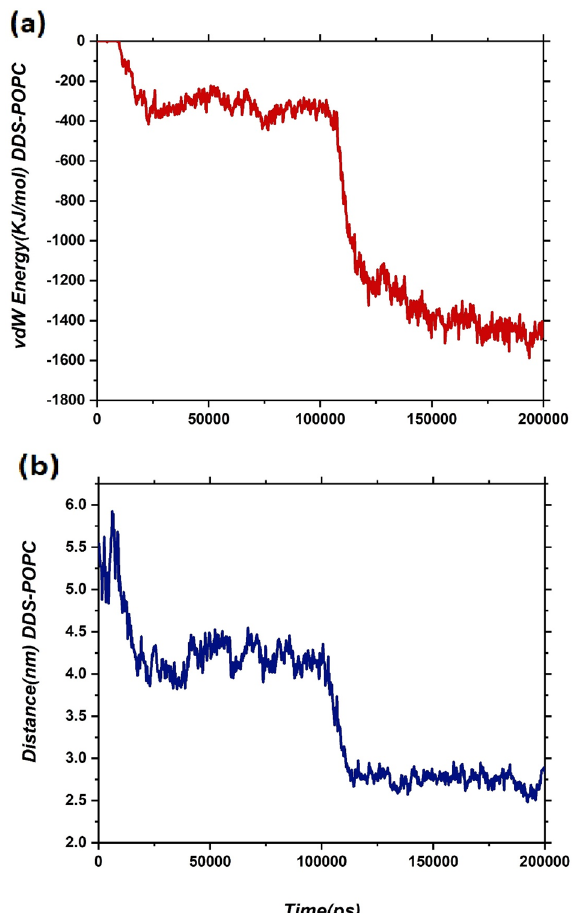
Figure 8. ( a ) Van der Waals energy and ( b ) COM distance between CN-DOX complex and lipid bilayer as functions of simulation